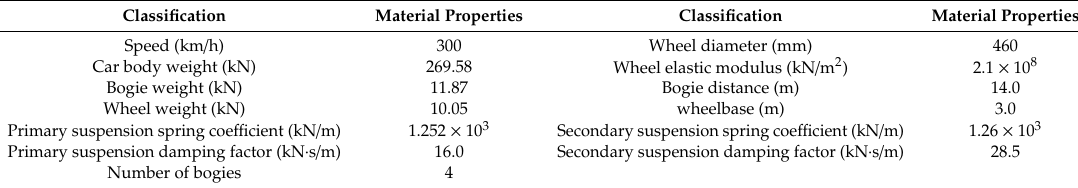
Figure 14. Diagram of vehicle model. Table 1. Material properties of vehicle model.